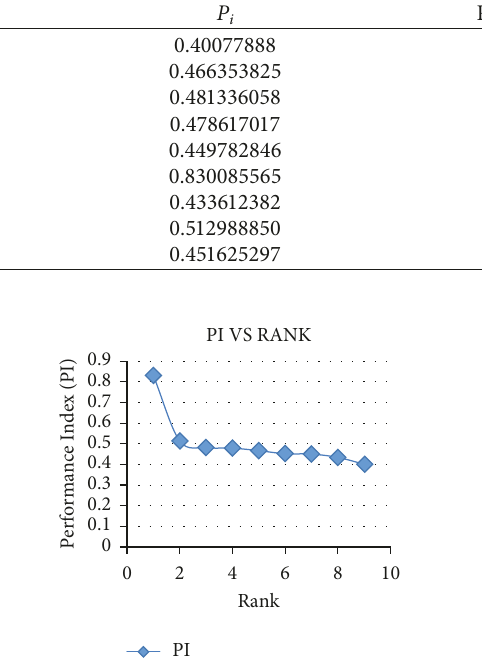
Figure 3: P i versus rank for zinc-coated wire as a tool.